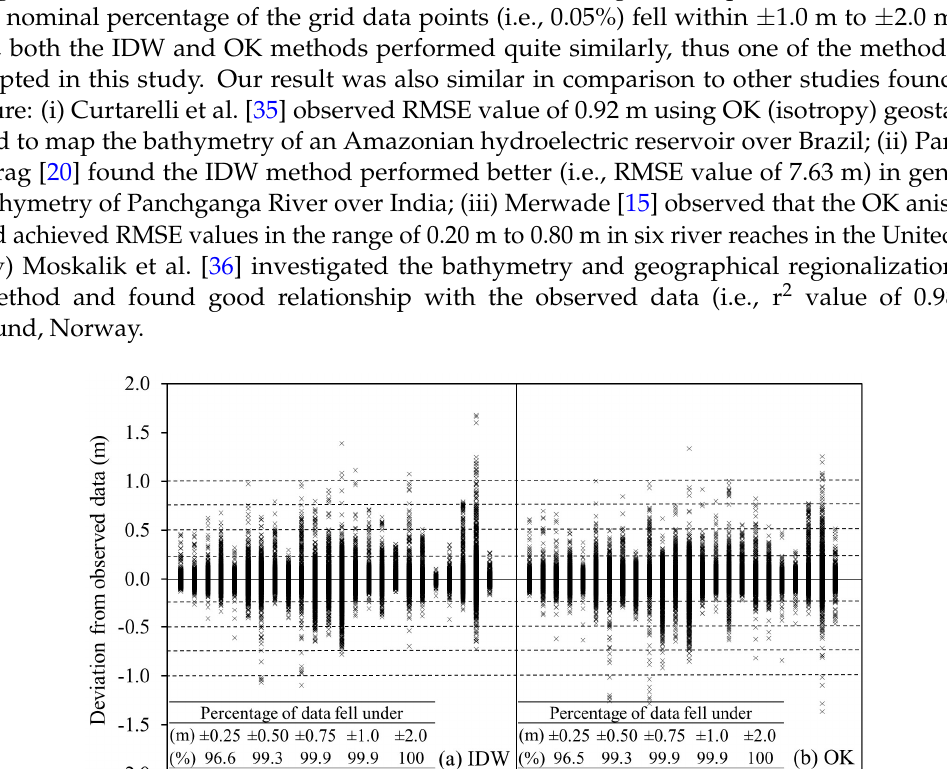
Figure 6. Deviation of the predicted values from the observed data for both ( a ) IDW and ( b ) OK methods in selected 24 sections.